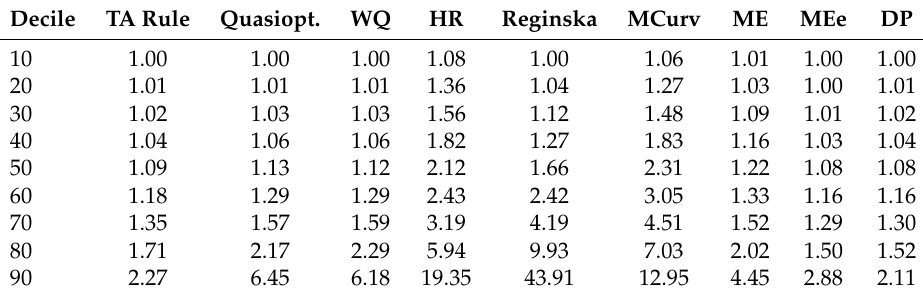
Table 5. Distribution of error ratios E in different